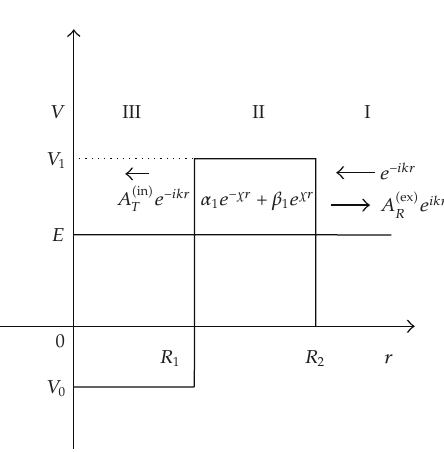
Figure 9: Schematic description of the impact of the wave with the barrier from